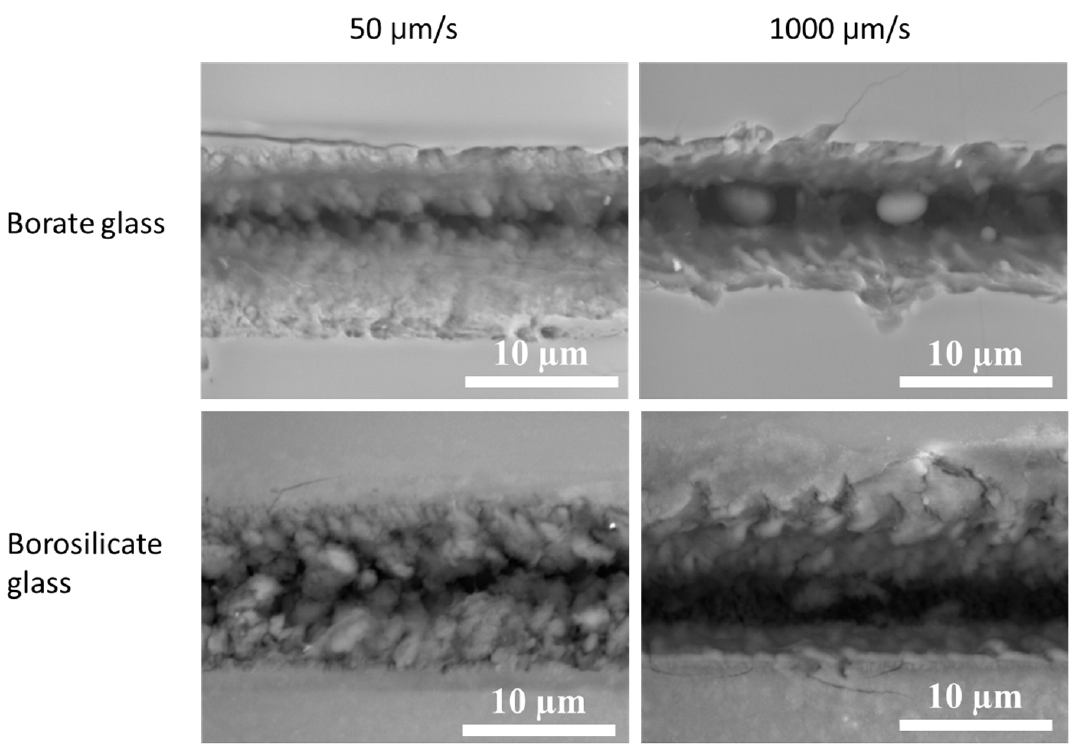
Figure 5. Scanning electron microscopy images of borate and borosilicate glass for scan speeds of 50 and 1000 µ m/s (NA = 0.65 and E = 3.5 µ J). For 50 µ m/s the sample is subjected to 40 pulses/spot (~2 µ m) and each spot experiences a fluence of 4.5 kJ/cm 2 , while 1000 μm/s corresponds to 2 pulses/spot (0.2 kJ/cm 2 per